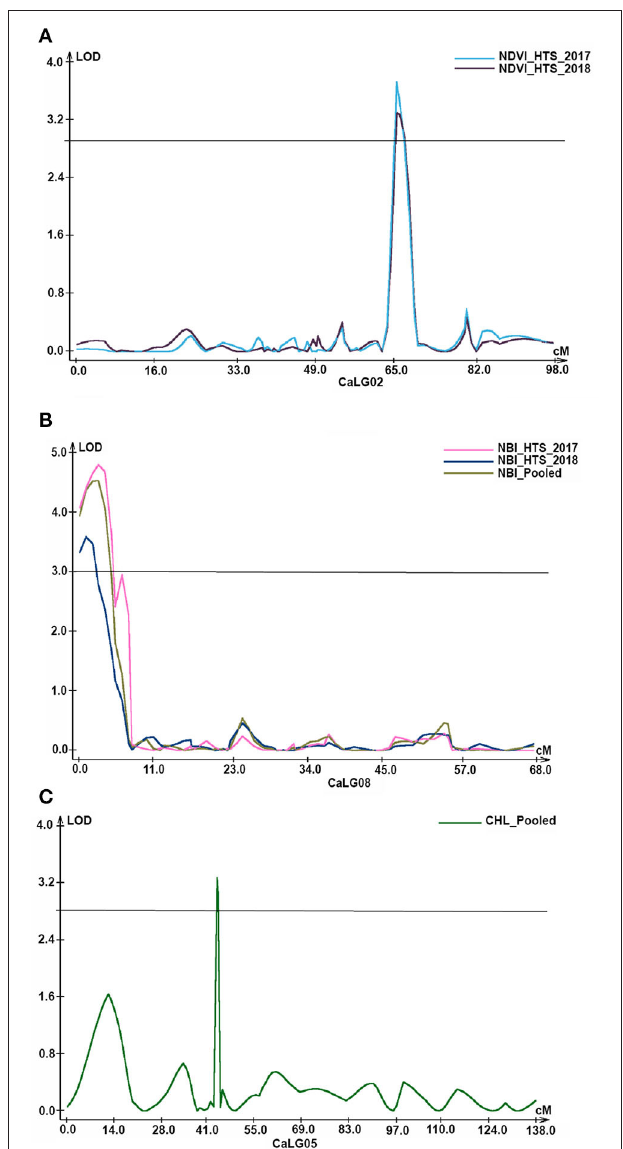
FIGURE 3 | Genomic regions with major QTLs for physiological traits. (A) Under heat stress environments of 2017–18 and 2018–19, two QTLs explaining 8.84% and 9.85% PVE, respectively, for normalized difference vegetation index (NDVI) were identified on CaLG02; (B) similarly, in addition to QTLs under two heat stress environments, QTLs for nitrogen balance index (NBI) were also identified based on pooled data on CaLG08; (C) a major QTL explaining 15.04% PVE for chlorophyll content on CaLG05 based on pooled data of under heat stress environments of 2017–18 and